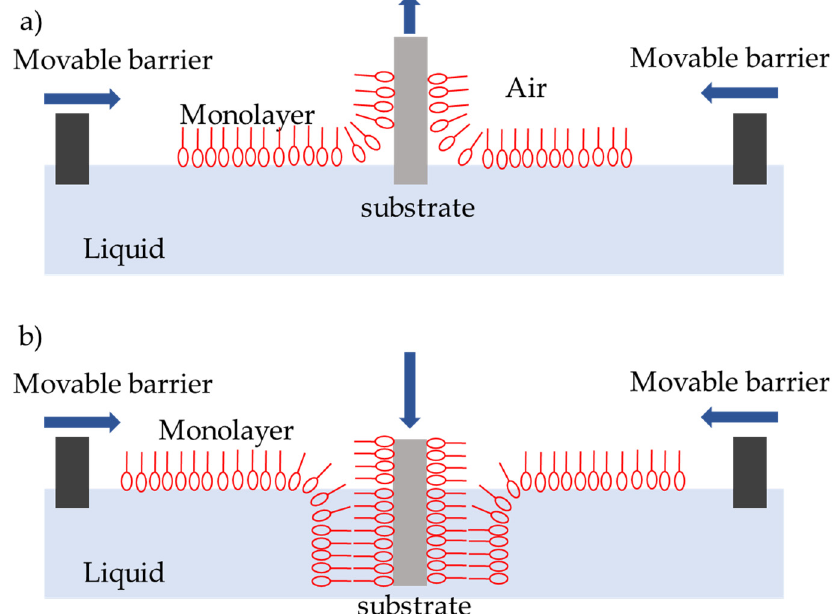
Figure 6. Langmuir–Blodgett thin film deposition: ( a ) first layer deposition on a hydrophilic surface; ( b ) second layer deposition on a hydrophobic layer.